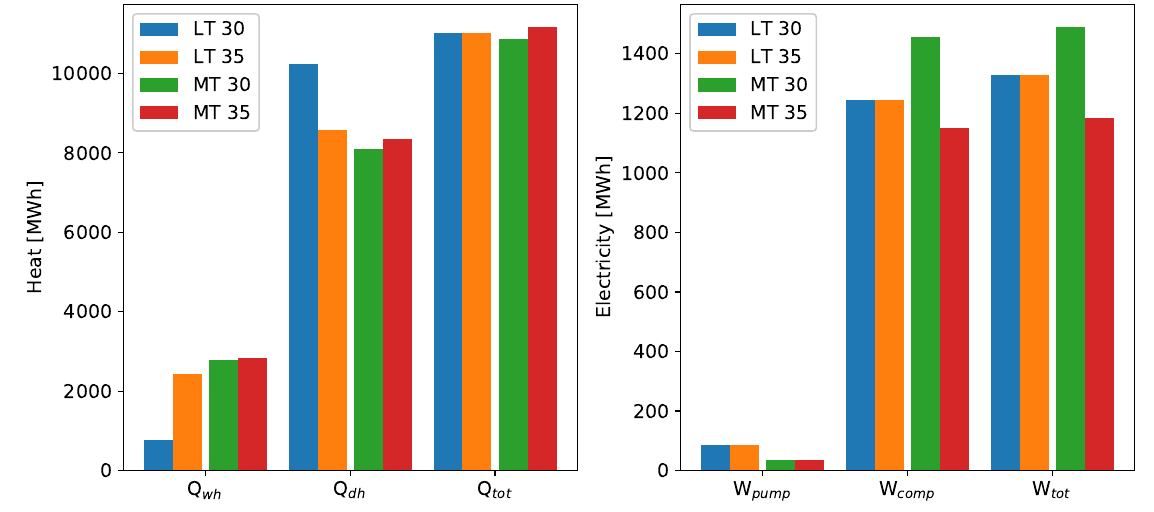
Figure 4. The heat supplied through waste heat and DH ( left ) and electric energy for pumps and compressors ( right ) for the LT and MT cases with waste heat temperatures of 30 and 35 ◦